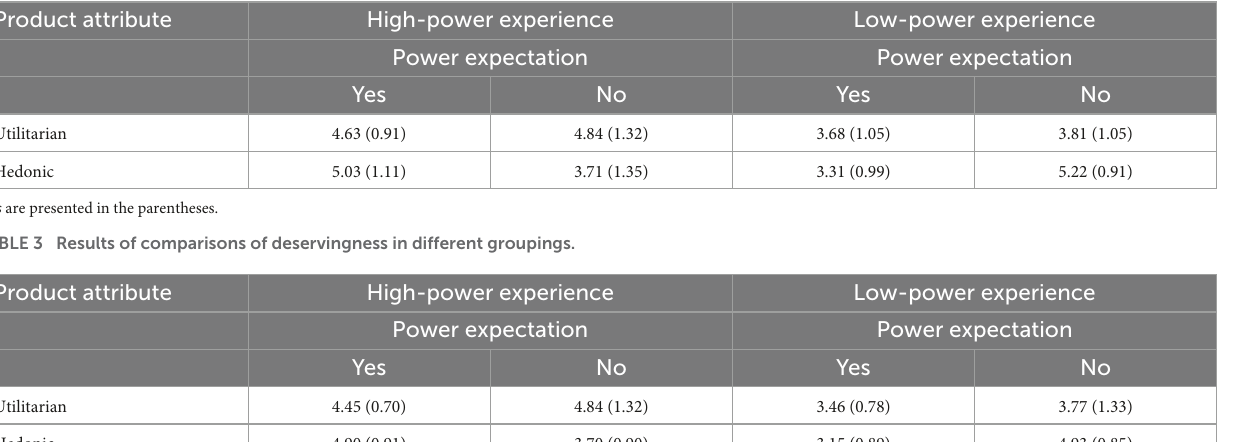
TABLE 2 Comparisons of purchase impulsiveness when the power expectation was activated or not.